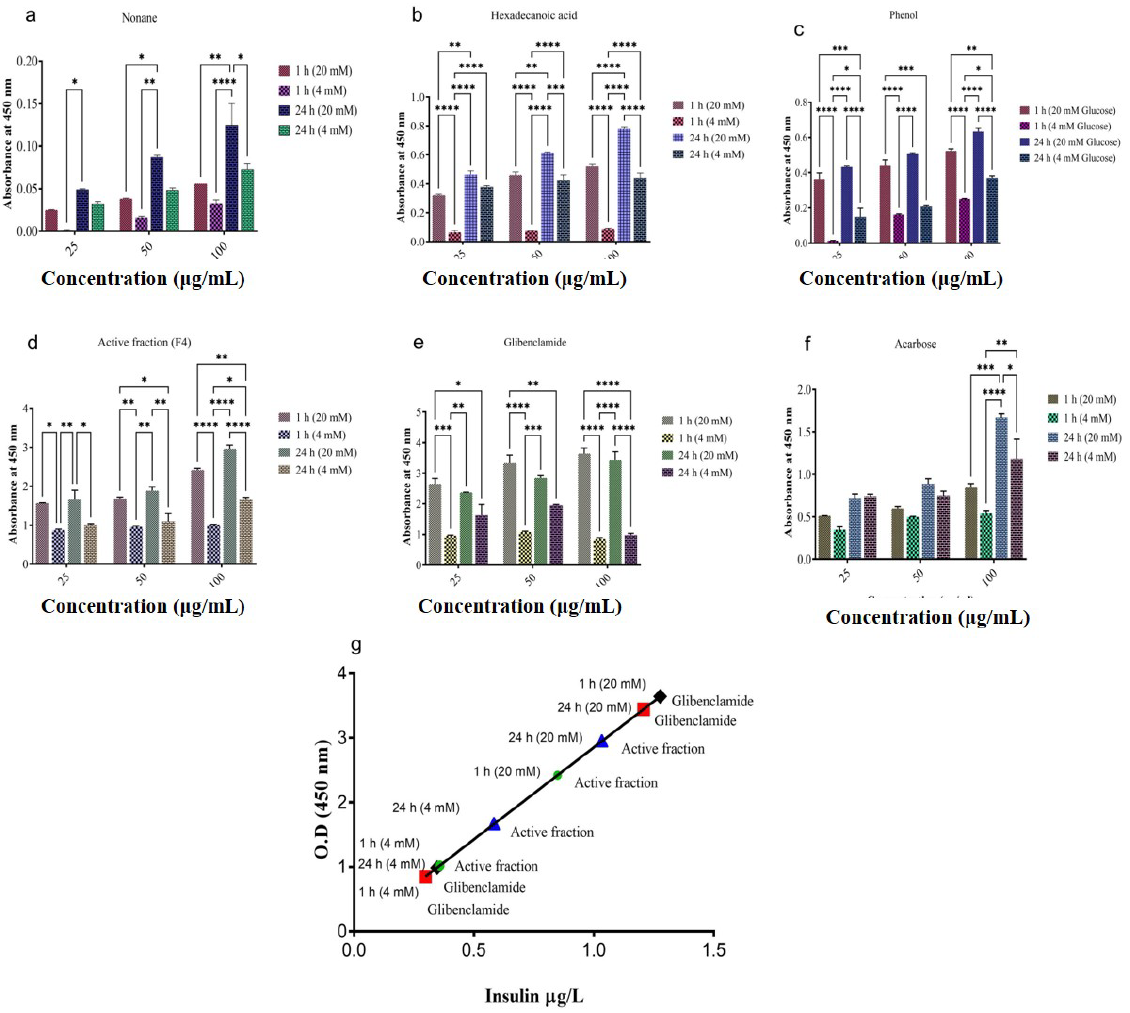
Figure 11. In vitro insulin secretion studies. Effect of isolated compounds and its active fraction (F4) on glucose-induced (4 mM and 20 mM) insulin secretion from pancreatic islets in 1 h and 24 h in vitro culture. Insulin secretagogue activity of isolated compounds and standard drugs ( a – f ), the concentration of insulin released in glucose-induced (4 and 20 mM) insulin secretion at 1 and 24 h in vitro culture ( g ). Values are means ± S.E.M ( n = 3). Mean values were analyzed using two-way ANOVA (Tukey’s multiple comparisons test). **** p < 0.0001, *** p < 0.001, ** p < 0.01, * p < 0.05 considered as